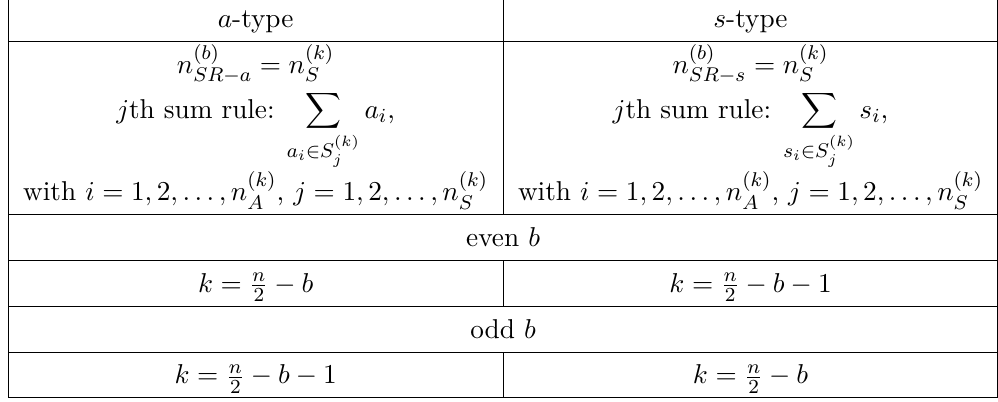
Table 8 . Summary of the a - and s -type sum rules at even and odd orders of U -spin breaking b . Note that k takes different values for a - and s -type sum rules. This means specifically, that the respective sums of the a and s go over different sets S ( k ) i i j